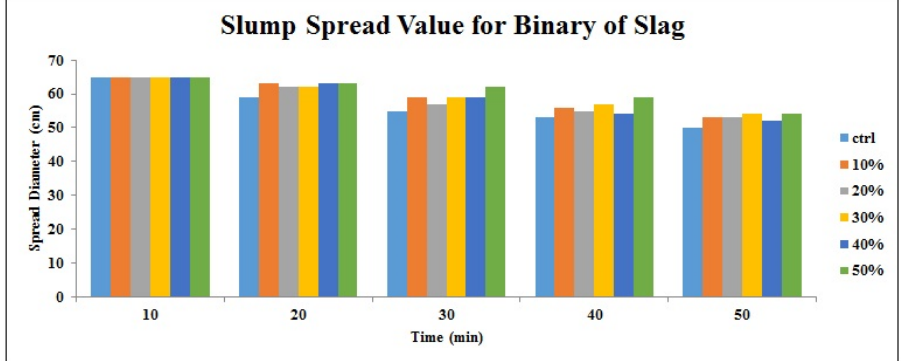
Figure 6. Slump value for slag powder samples throughout the first 50 min.